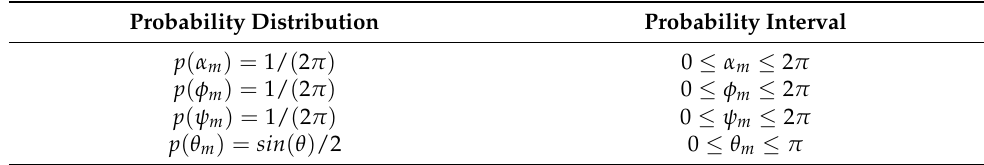
Figure 4. The schematic representation of the solution procedure. ( a ) scheme of the pre-processing block diagram; ( b ) scheme of the main loop block diagram. Table 2. Probability distribution of random functions